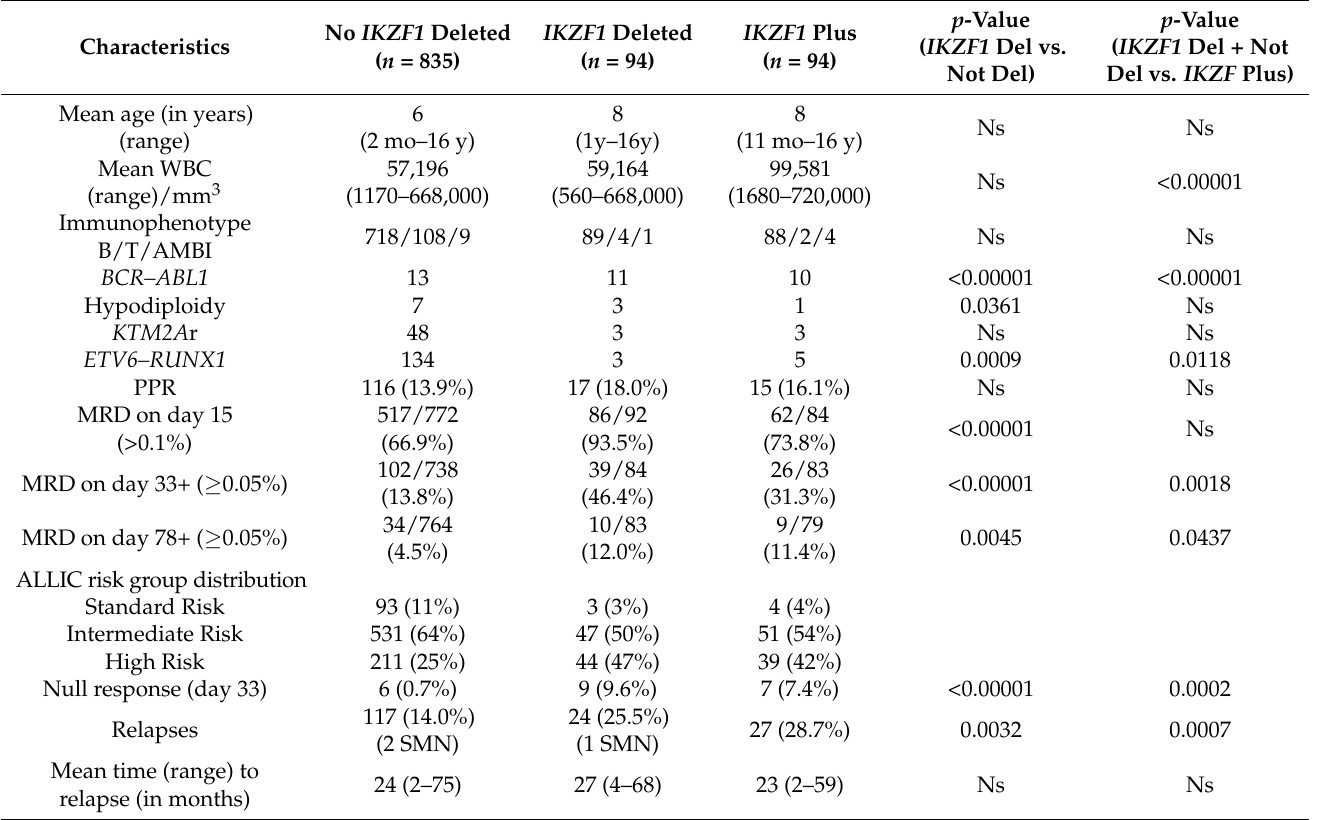
Table 1. Comparison of biological features and response to treatment according to IKZF1